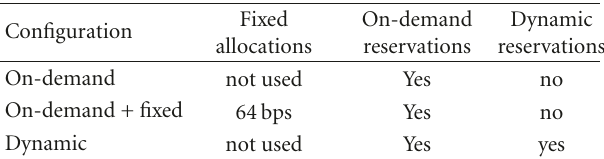
Table 3: Configurations used in the slot allocation method simulations.